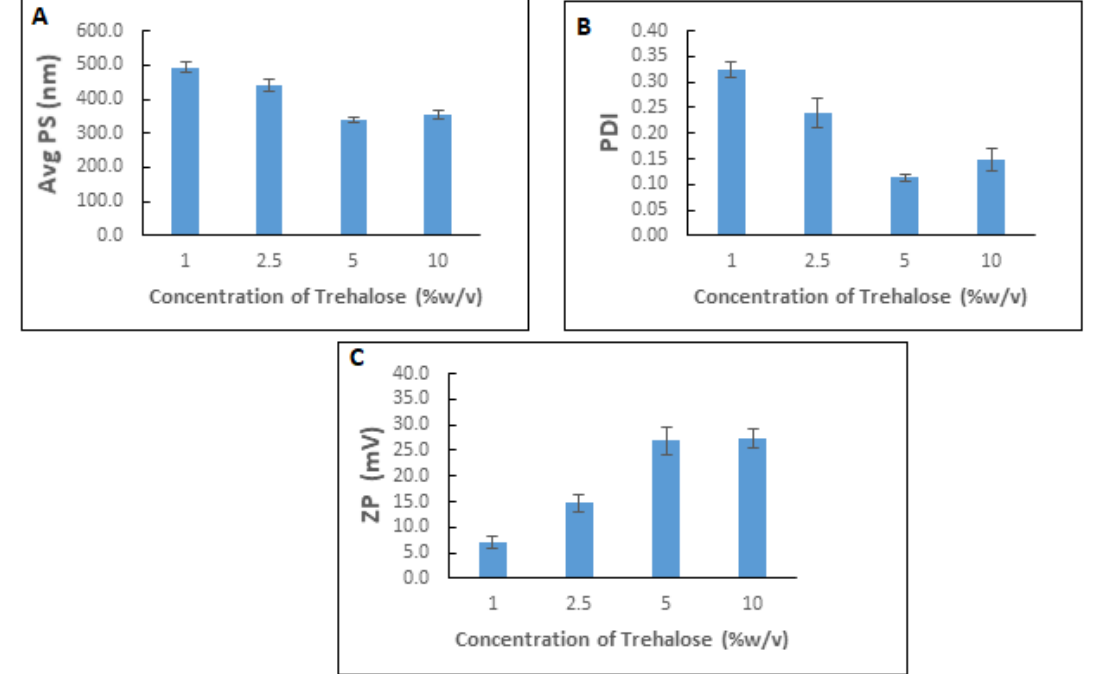
Figure 3. Effect of trehalose as cryoprotectant on ( A ) particle size, ( B ) polydispersity index (PDI), and ( C ) zeta potential. There was no significant difference ( p > 0.05) was observed for zeta potential at 5% and 10% of trehalose).